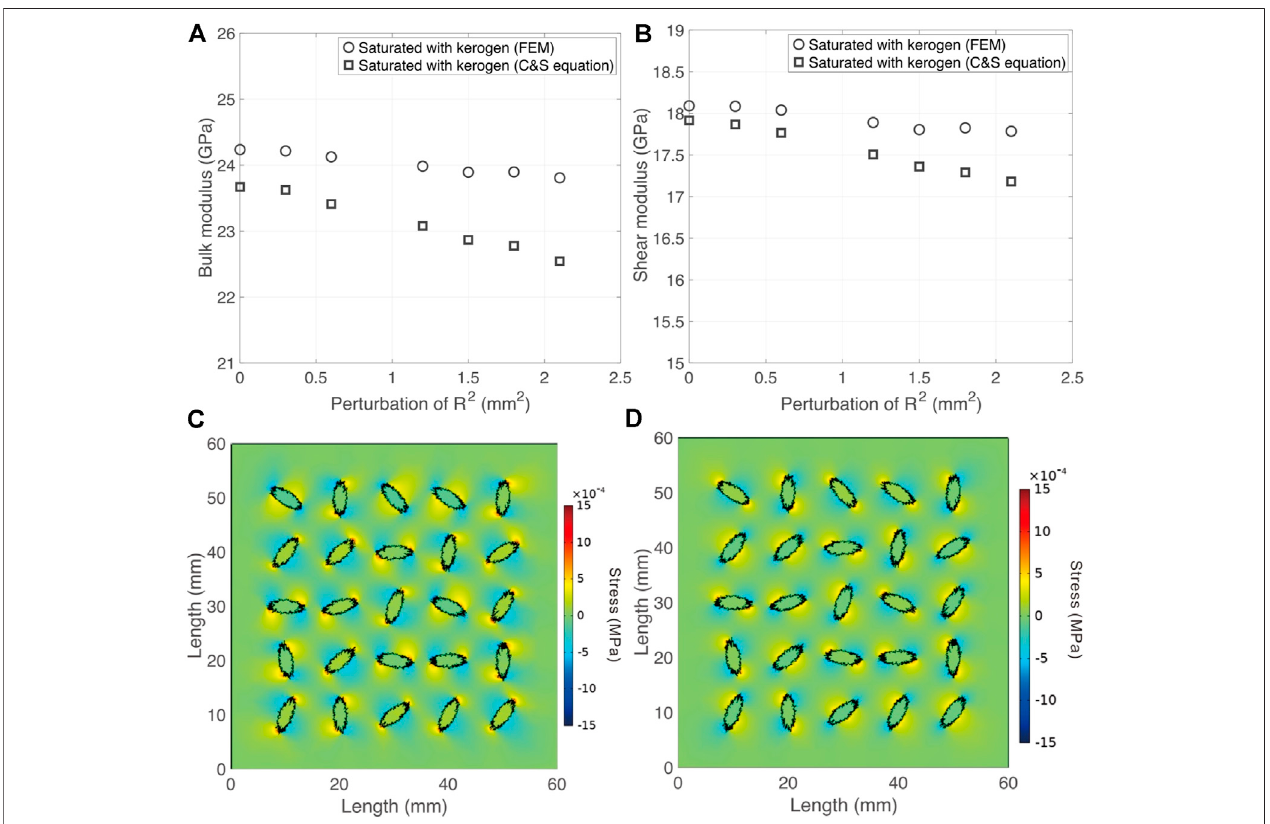
FIGURE8|(A) Thevariationofbulkmoduliofkerogen-saturatedsamplesvs.theperturbationof R 2 , (B) thevariationofshearmoduliofkerogen-saturatedsamples vs. the perturbation of R 2 , (C) the distribution of shear stress when the sample loaded by normal stress, (D) the distribution of normal stress when the sample loaded by shear